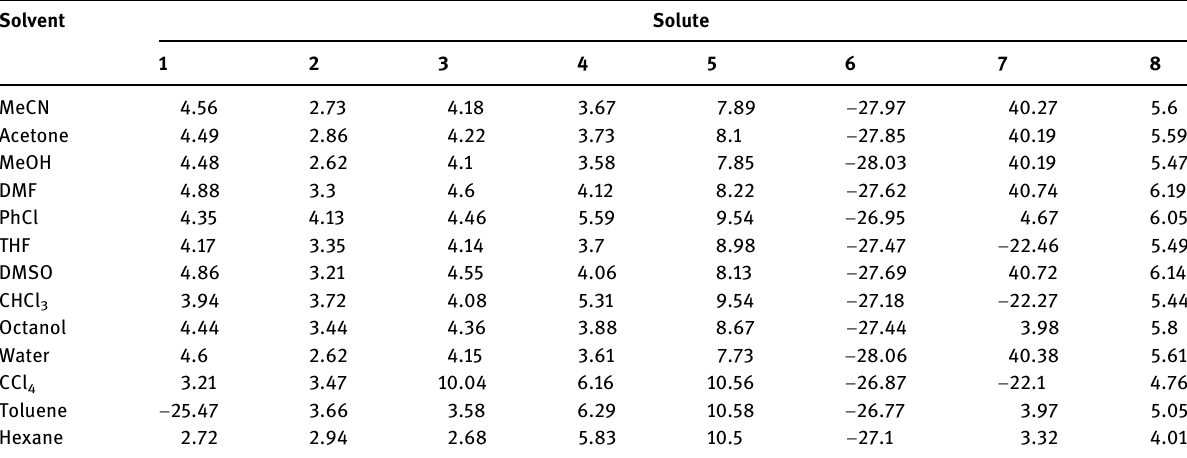
Table 11: Calculated di ff erences between values of λ max for azoles 1 – 8 at the CAM - B3LYP/6 - 311 ++ G ( 2d,3p ) //CAM - B3LYP/6 - 31G ( d,p ) level of theory in the PCM solvation model and the gaseous phase ( Δ λ max [ nm ]) Solvent Solute